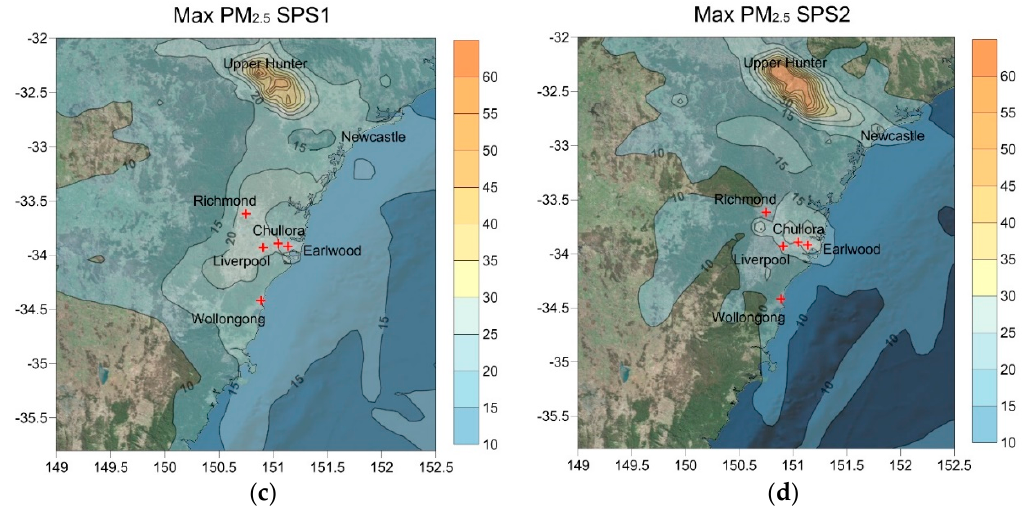
Figure 8. Spatial distribution of PM 2.5 concentrations ( µ g/m 3 ) predicted by CCAM-CTM with GMR 9-km horizontal resolution domain. The hourly average PM 2.5 concentrations for the period of ( a ) SPS1 and ( b ) SPS2; and the hourly maximum PM 2.5 concentrations for the period of ( c ) SPS1 and ( d ) SPS2. Red cross signs indicate locations of OEH stations where PM 2.5 measurements are available.